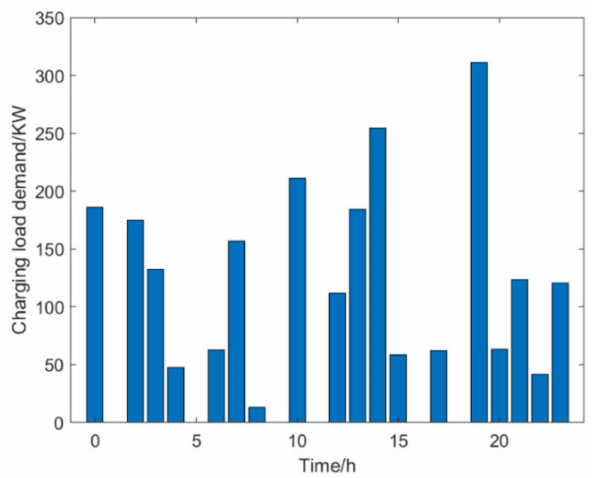
Figure 23. Charging load demand of No. 34 charging station.